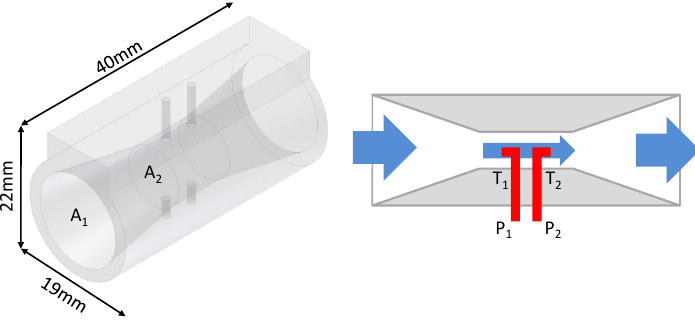
Figure 2. Design of the air duct and representation of the principle of the Pitot tubes of the near-body air flow system.